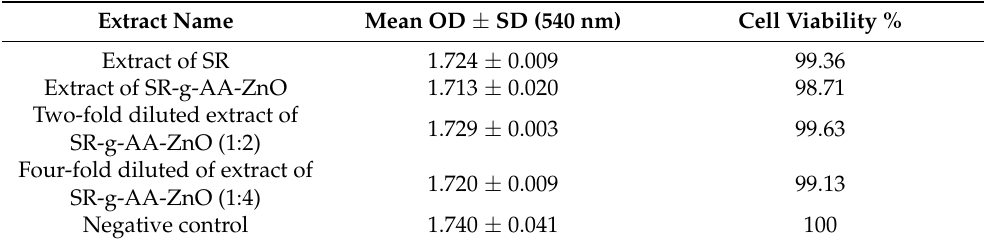
Table 4. Cell viability % of normal human oral epithelial cells (OEC) with extracts of SR and SR-g- AAc-ZnO segments.